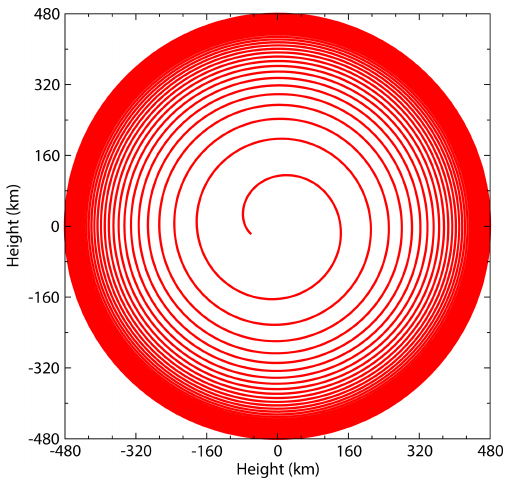
Figure 4. Orbital degradation of a hypothetical satellite in a nomi- nally circular orbit due to atmospheric drag. Source: adapted from Nwankwo,